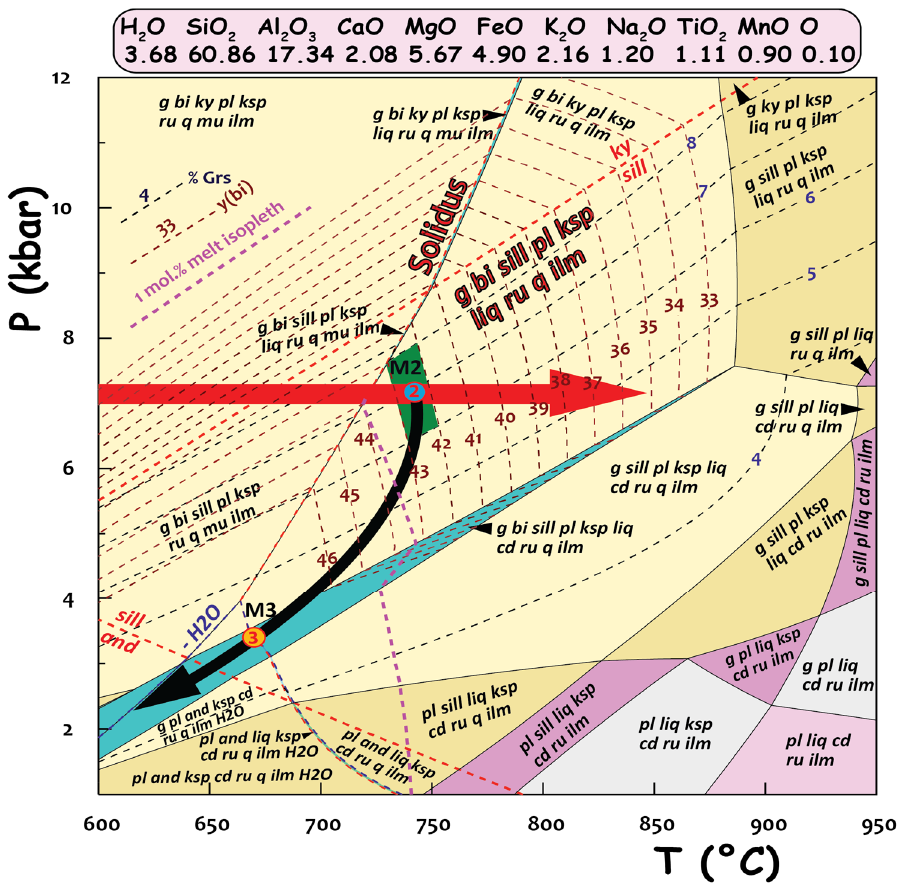
Figure 9. P-T pseudosection calculated using the MnNCKFMASHTO chemical system with the measured bulk composition (SEM-EDS) of migmatitic paragneisses with the proposed prograde P-T path (the red line with arrow). The red thick dashed line is the solidus; the blue, brown, and pink thin dashed lines correspond to the isopleths of the grossular (Grs) content of garnet, the y(bi) in biotite, and melt, respectively. The red bold fonts refer to the observed syn-thermal peak mineral assemblage. The semitransparent blue and yellow circles marked by numbers refer to the syn-thermal peak and retrograde metamorphic P-T conditions constrained by the observed mineral assemblages and the mineral composition isopleths. The black full line with an arrow represents the P-T path of the rock. See text for further